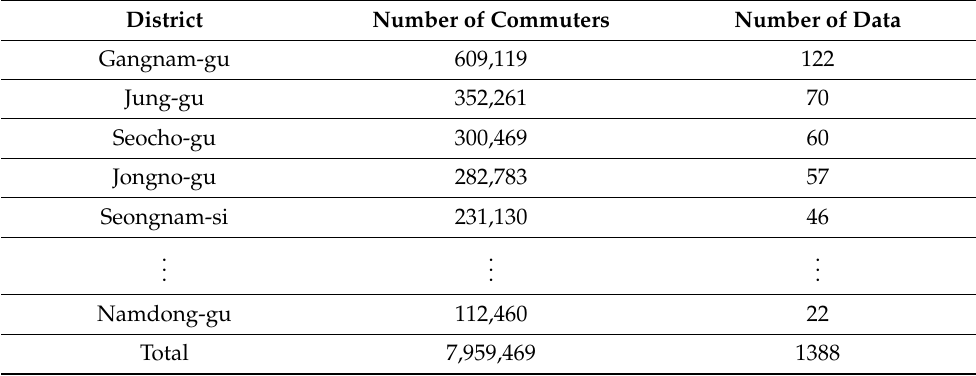
Figure 2. Administrative districts represented by squares. Table 2. Number of commuters and data in major district.